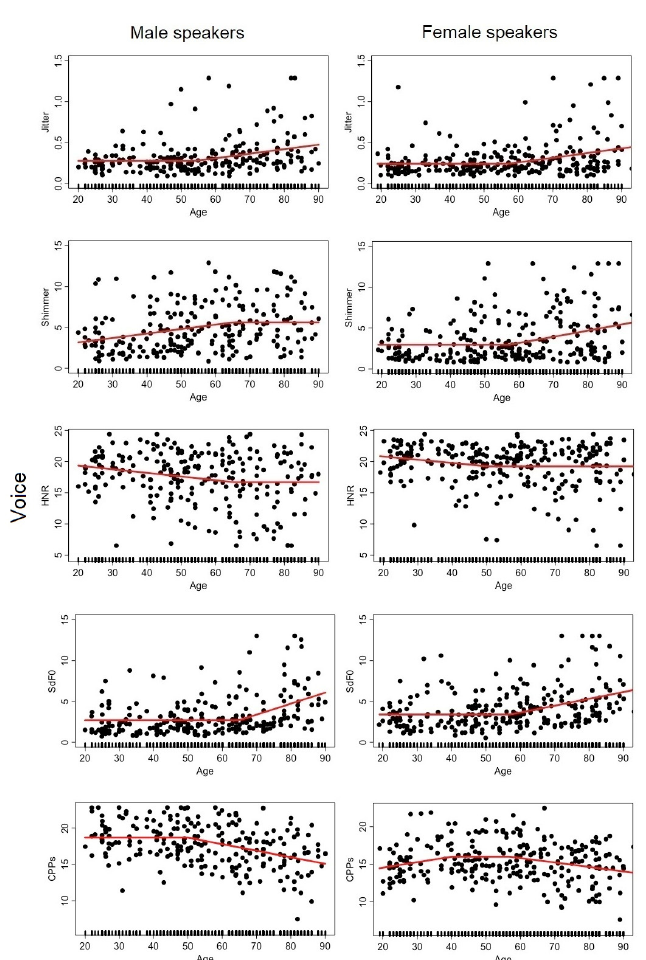
Figure A1. Dot plot of each descriptor ( y -axis) capturing aspects of the VOICE dimension as a function of age ( x -axis) for the male ( left ) and female ( right ) speakers. The hinge function of the MARS model is represented by the red curve. Each dot corresponds to a speaker.